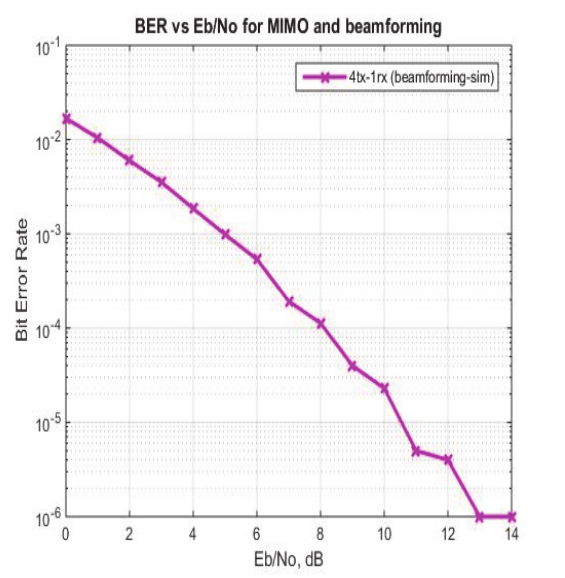
Fig. 3. BER vs E b / N o for 4 × 1 BF detector.